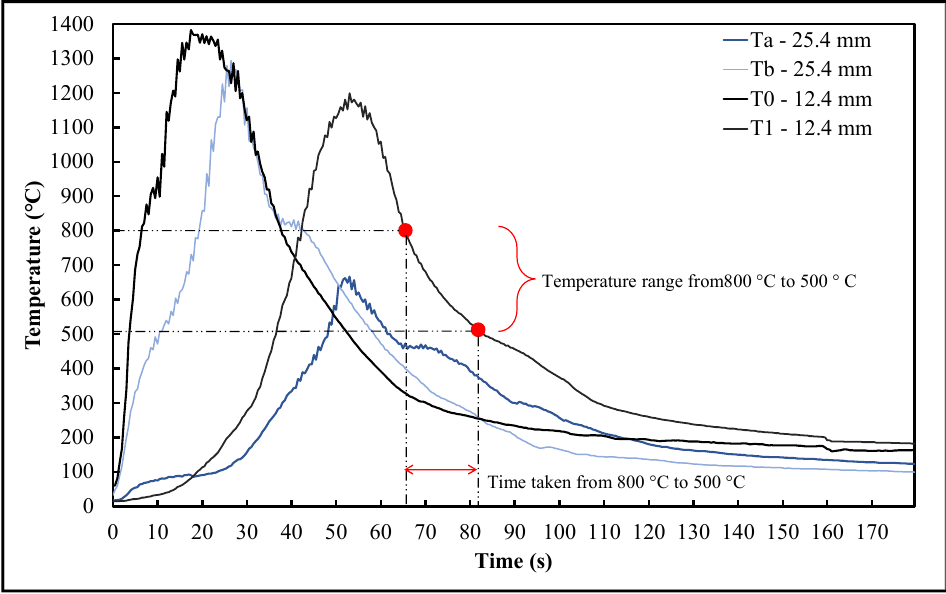
Figure 3. Examples of temperature curves obtained during the welding of the coatings on 12.4 mm and 25.4 mm thick substrates.